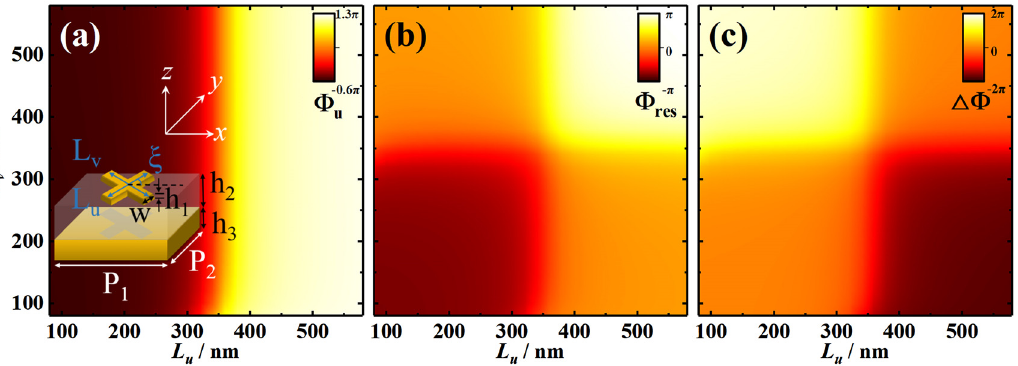
Figure 3: Meta-atom designs at the wavelength of 1550 nm. (a) finite-difference time-domain (FDTD) – computed reflection phase Φ u versus L u and L v for meta-atoms (see inset) under illuminations of (cid:18) u -polarized light. Other geometrical parameters of the meta-atoms are fi xed as h 1 = 30 nm, h 2 = 100 nm, h 3 = 125 nm, w = 80 nm, and P 1 = P 2 =600nm.(b)Resonancephase Φ res and(c)cross-polarizationphasedifference ΔΦ versus L u and L v ,computedbyFDTDsimulationsfor our meta-atoms. The working wavelength is set as 1550